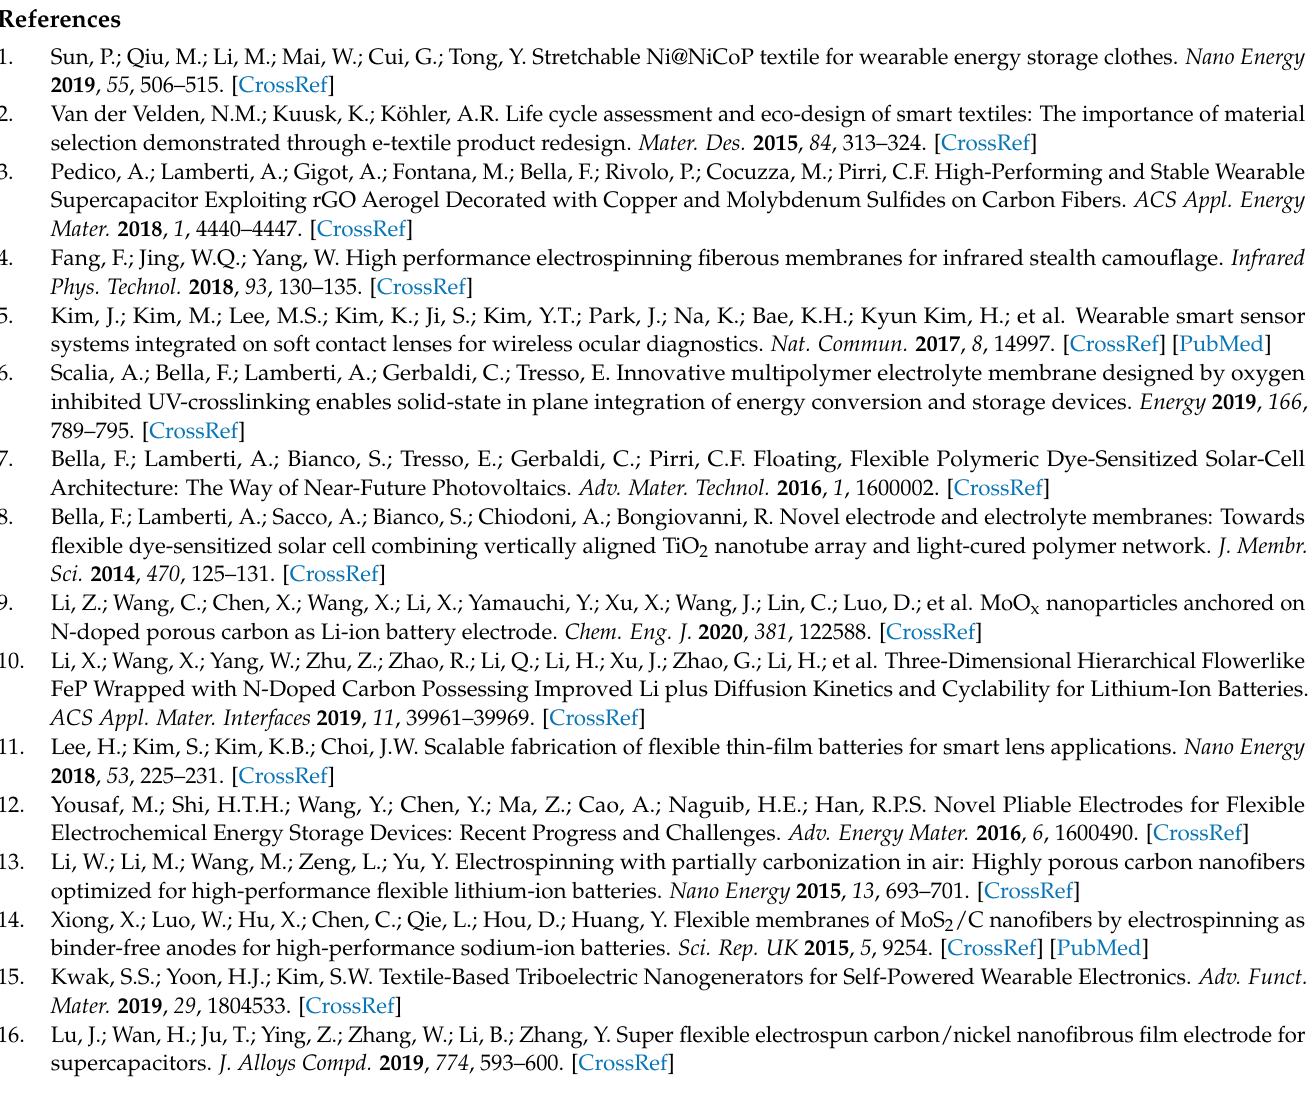
Figure S3. HRTEM image of the MoO2/C nanofibers; Figure S4: SEM image of (a,b) the MoO2/C nanofibers electrode after cycling, (c) MoO2 nanoparticles electrode and (d) MoO2 nanoparticles electrode after cycling; Figure S5: Cycling performance and corresponding coulombic efficiency of the carbon nanofibers at 200 mA g − 1